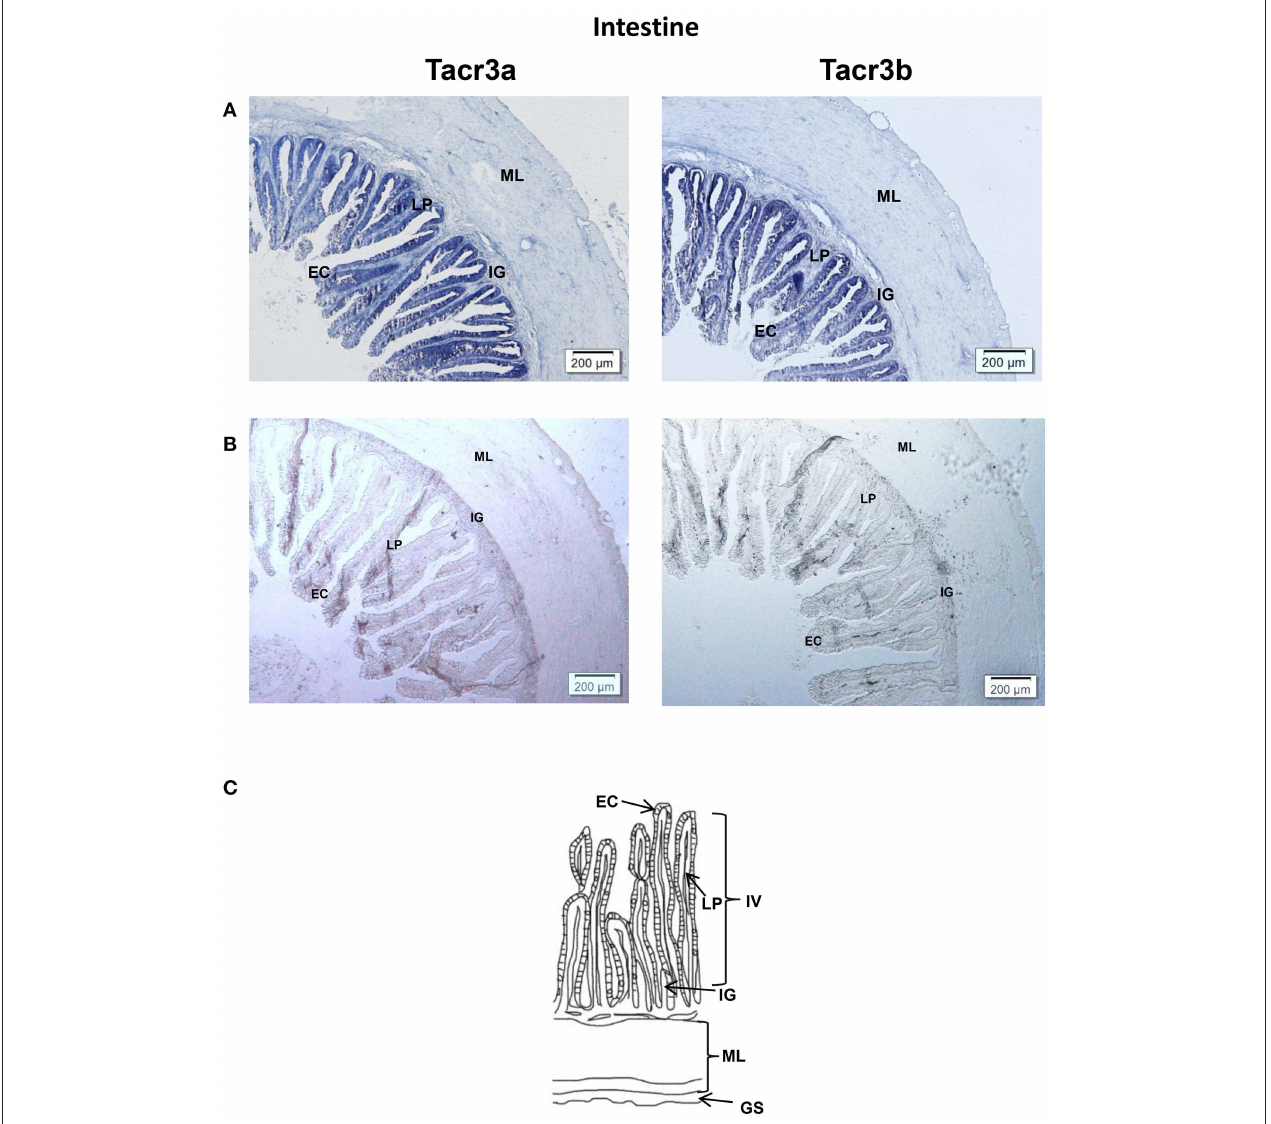
FIGURE 9 | Photomicrographs and schematic illustrations of the mRNA levels of tacr3s in the intestine of the spotted sea bass, as detected by in situ hybridization (ISH). Positive signal of tacr3a and tacr3b in the intestine (A) . Photomicrographs of tacr3a and tacr3b sense probe results in the intestine (B) . Schematic diagram for intestine histology (C) . GS, gastric serosa; ML, muscular layer; IG, intestinal gland; IV, intestinal villus; LP, lamina propria; EC, epithelial